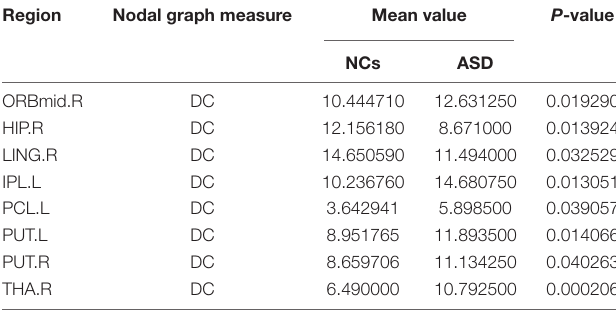
TABLE 6 | Between-group comparison in N C p . Region Nodal graph measure